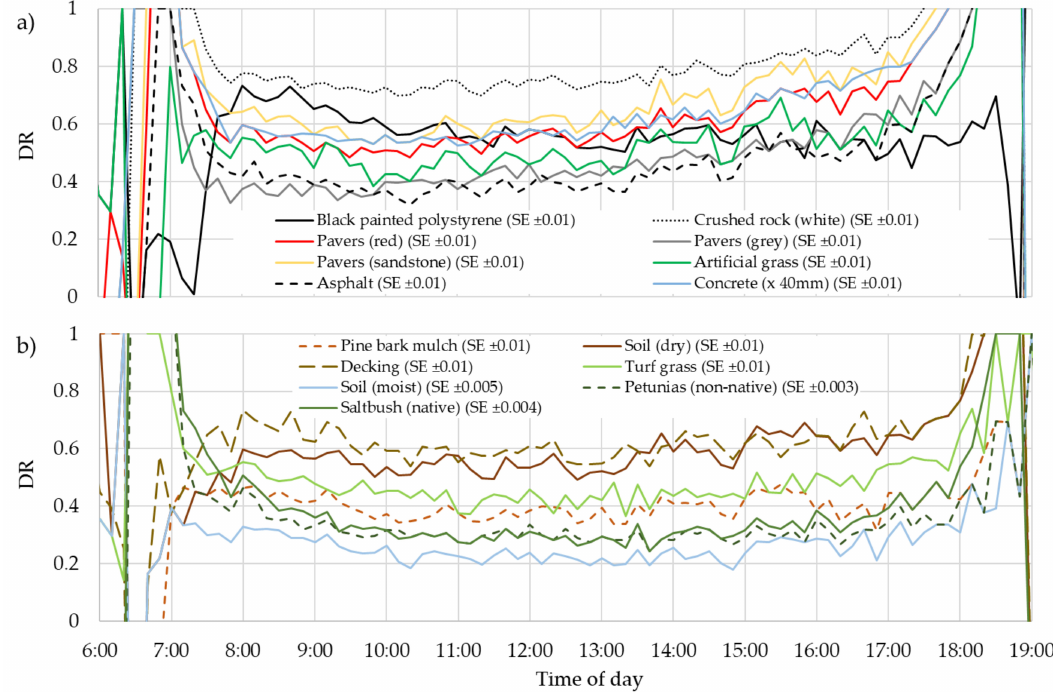
Figure 12. Daytime ratio (T iB,LE –T amb ) over (T iB,WPP –T amb ) for LEs, summer 2019 (21st January 2019). Comparison of: a) hardscape LEs; and b) softscape or natural LEs. Data from 09:00 to 15:40 were averaged. Standard errors (SE) were calculated assuming random errors and a normal distribution